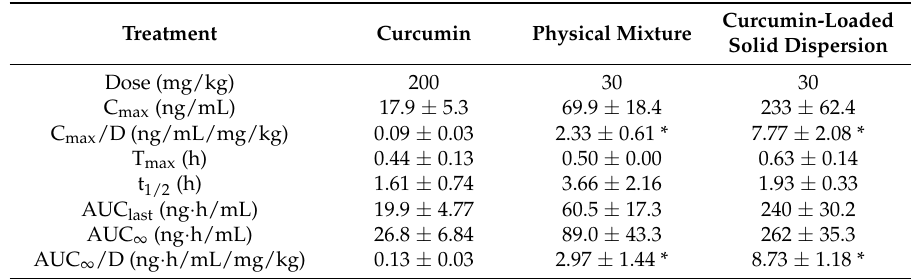
Table 1. Pharmacokinetic parameters of curcumin following per oral administration of curcumin, curcumin-loaded solid dispersion and its physical mixture.